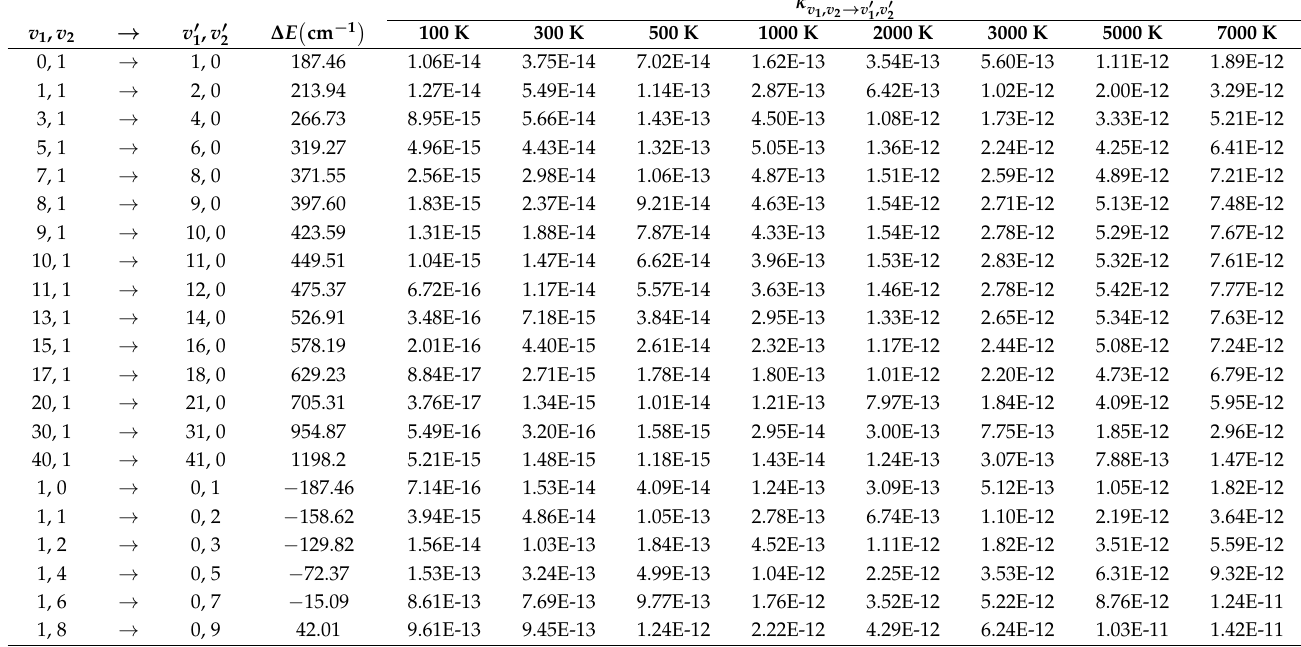
) + N ( v (cid:48) ) + ∆ E 2 2 1